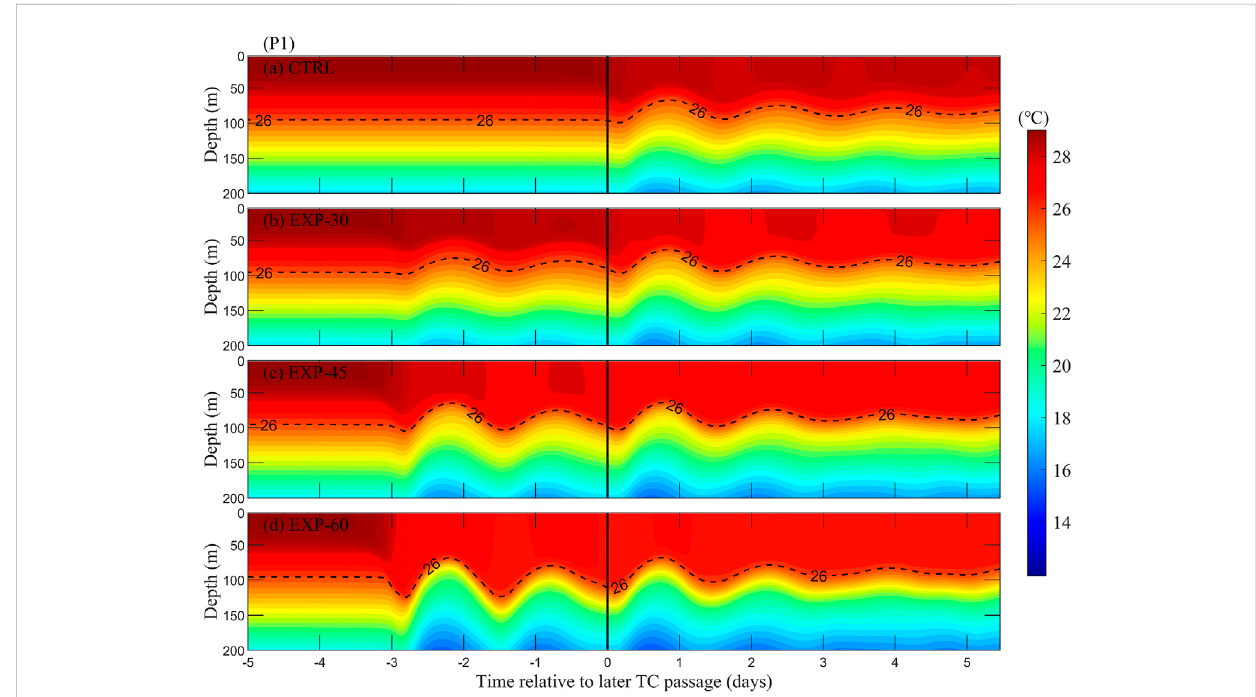
FIGURE 11 Time-depth cross-section of temperature ( ° C) at point P1 in different experiments. Day 0 is the arrival time of the LTC.